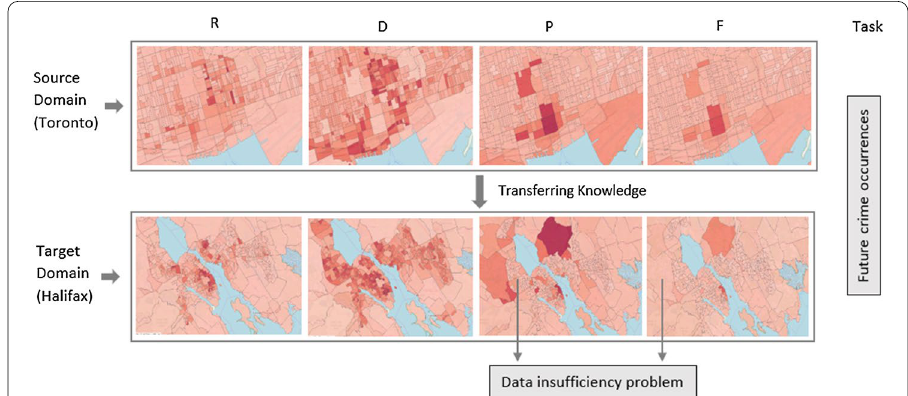
Fig. 6 Transferring knowledge from Toronto (source) to Halifax (target). R: Raw features, D: Demographic features, P: Foursquare POI features and F: Foursquare dynamic